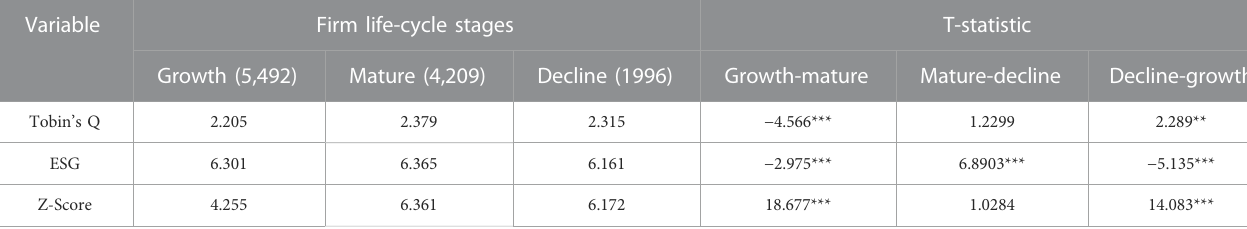
TABLE 6 Descriptive statistics at different life cycle